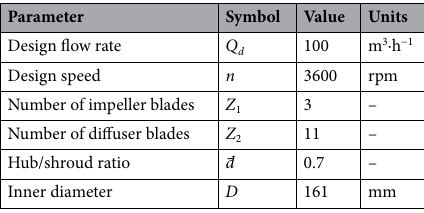
Table 1. Main design parameters.